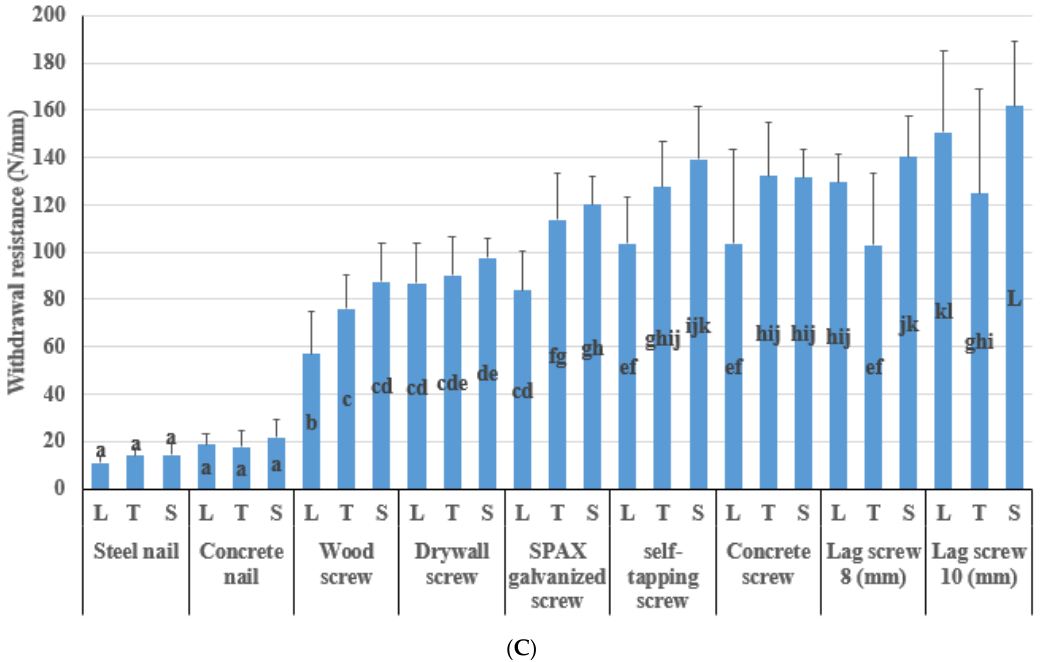
Figure 5. Interaction effects layer arrangements, loading directions, and types of fasteners on the withdrawal resistance of CLTs. ( A ) CLT types * Fastener types. ( B ) CLT types * Loading directions. ( C ) Fastener types * Loading directions.